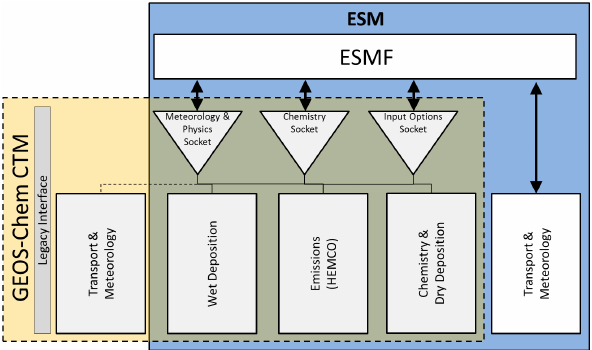
Figure 1. Coupling between the GEOS-Chem global chemical transport model (CTM) (dashed beige box) and an Earth system model (ESM) (blue box). The schematic shows how the coupling is managed through the ESMF, and utilizes only the GEOS-Chem components bound by the ESM box: transport modules in the GEOS-Chem CTM are bypassed and replaced by the ESM trans- port modules through the atmospheric dynamics